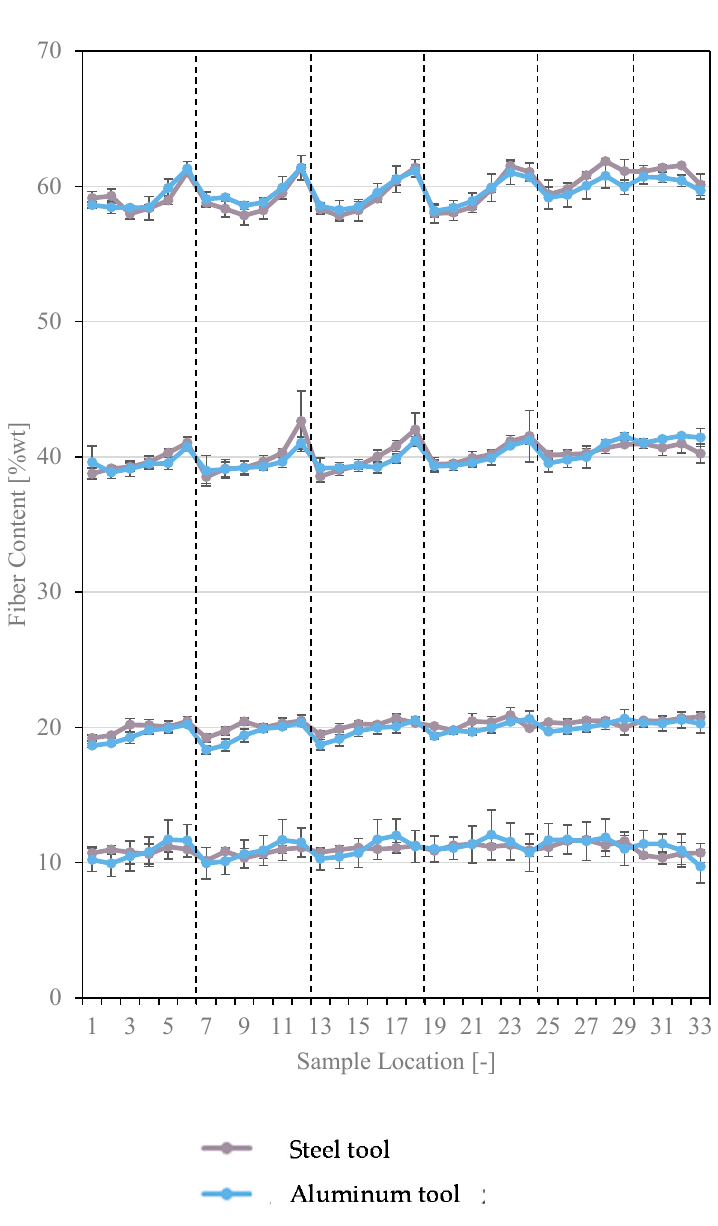
Figure A8. Fiber content distribution for disc segments of 10, 20, 40, and 60 wt.% initial nominal fiber content at different locations (1–33 in accordance with Figure 7) for steel tools and aluminum tools.